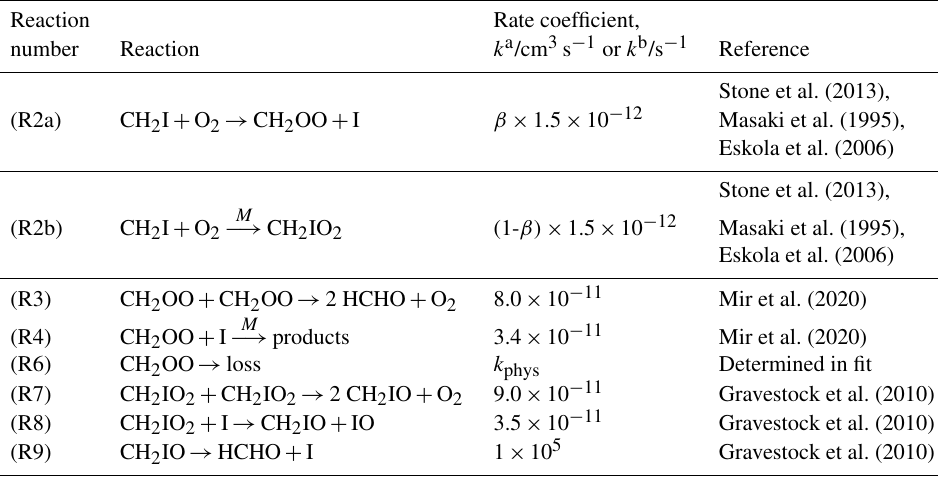
a Second-order reactions. b First-order